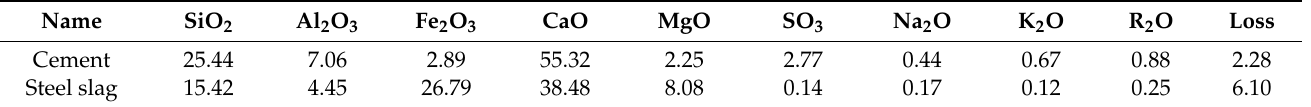
Table 1. Chemical composition of raw materials (Mass fraction